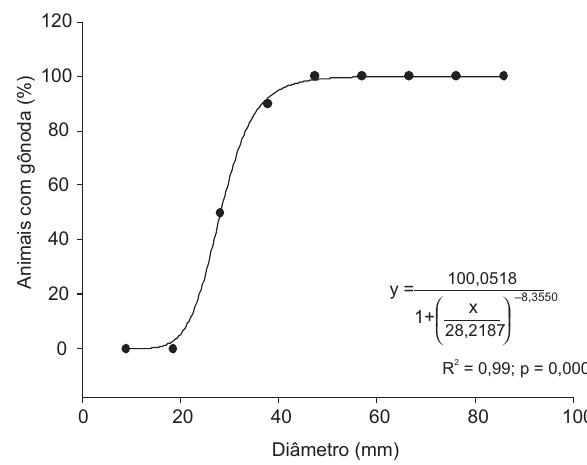
Figura 5. Porcentagem de indivíduos com gônada nas diversas classes de diâmetro corpóreo para a população de E. lucunter , na praia da Costa, Espírito